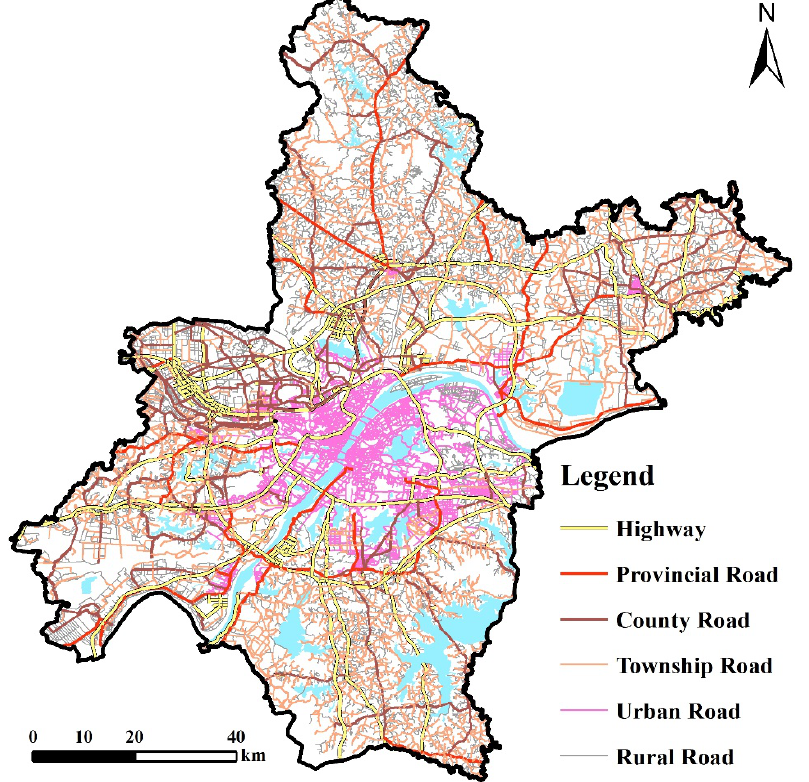
Figure 3. Traffic network of Wuhan City.